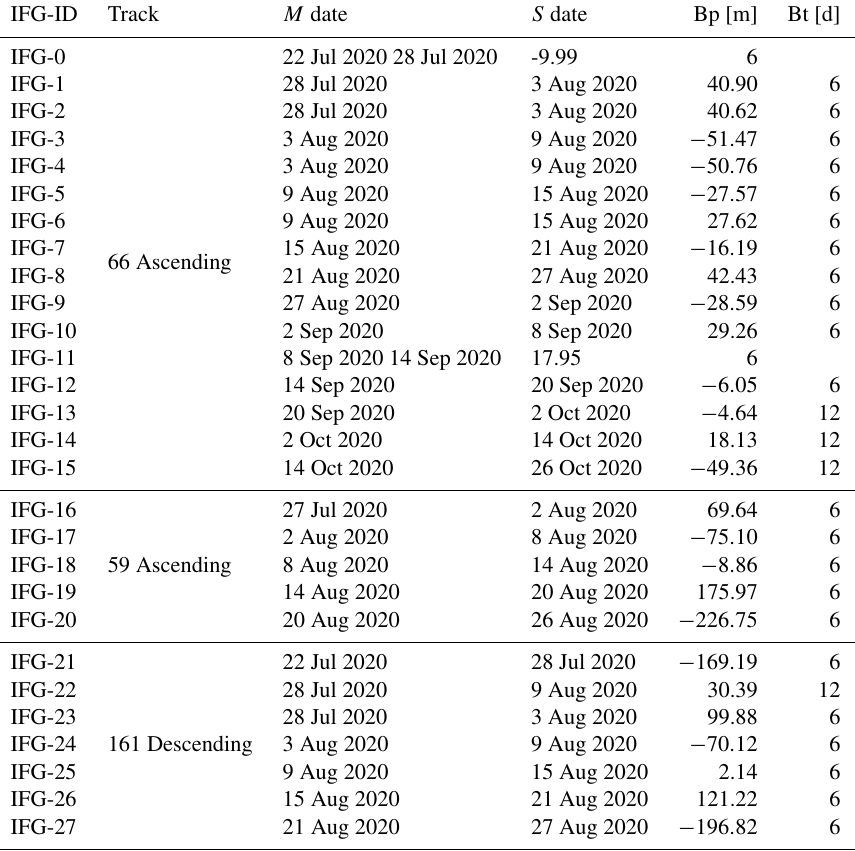
Figure 3. Ground cracks due to landslides in Kherba, Mila, ∼ 2 . 5m offset towards the north. (a) Drone aerial photo from LNHC (2021). (b, c) Lateral displacements (photos: courtesy M. Yacoub Ali, University of Setif, Algeria). Table 1. Characteristics of Sentinel-1 InSAR pairs used for this